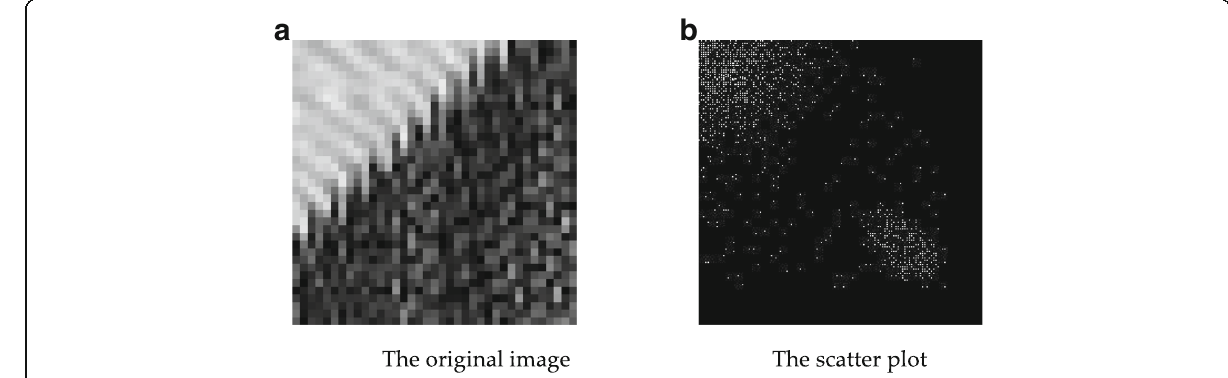
Fig. 2 The original image and its scatter plot of the spatial dependency of